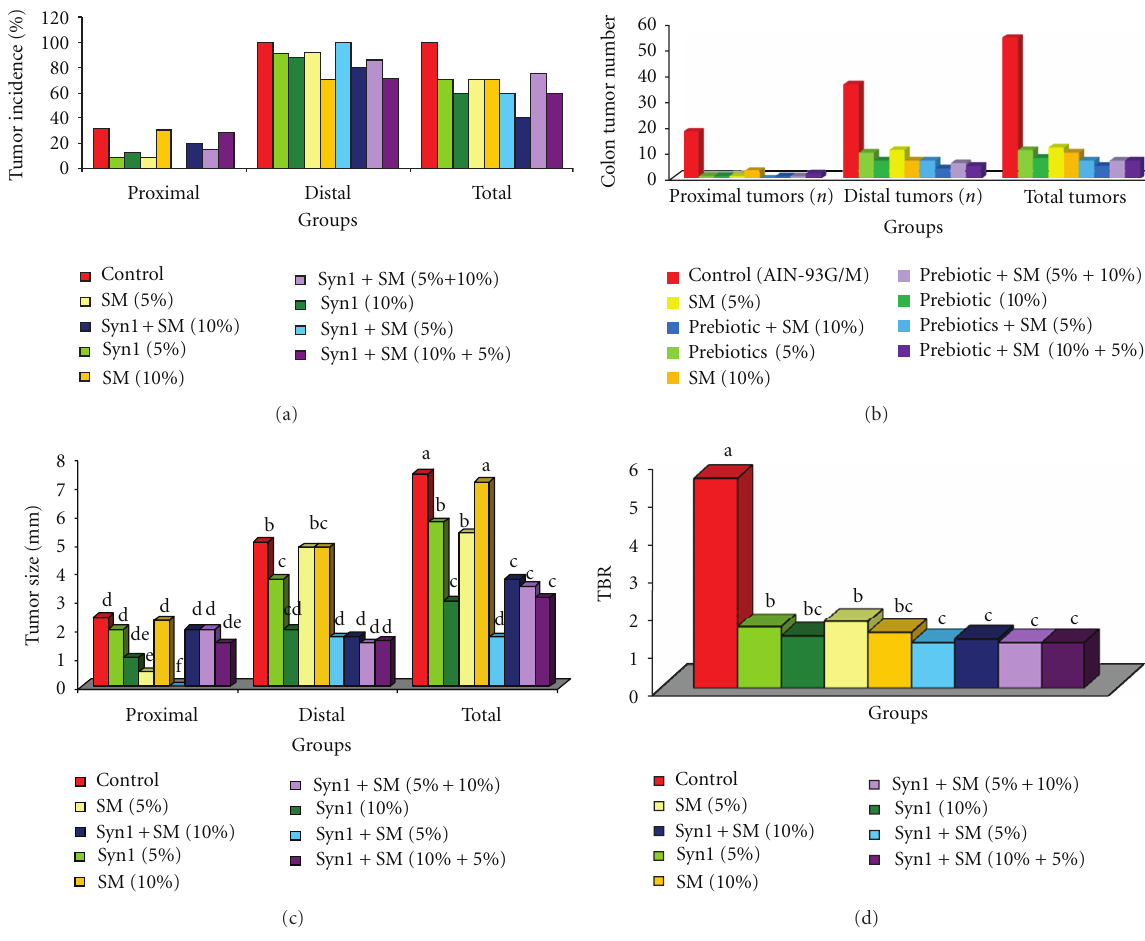
Figure 2: (a) E ff ect of feeding prebiotics and soybean meal on colon tumor incidence (percentage) in F344 male rats. (b) E ff ect of feeding prebiotics and soybean meal on colon tumor number ( n ) in F344 male rats. (c) E ff ect of feeding prebiotics and soybean meal on colonic tumor size (mm) in F344 male rats. Values are expressed as means ± SEM. abcdef Bars with same letter are not significantly di ff erent using Tukey’s studentized range test ( P ≤ 0 . 05). (d) E ff ect of feeding prebiotics and soybean meal on tumors per tumor bearing rat ratio (TBR) in F344 male rats. N 1 represents the number of rats with tumors; N 2 is total number of rats at the end of the experiment. Values are expressed as means ± SEM. abc Bars with same letter are not significantly di ff erent using Tukey’s studentized range test ( P ≤ 0 .